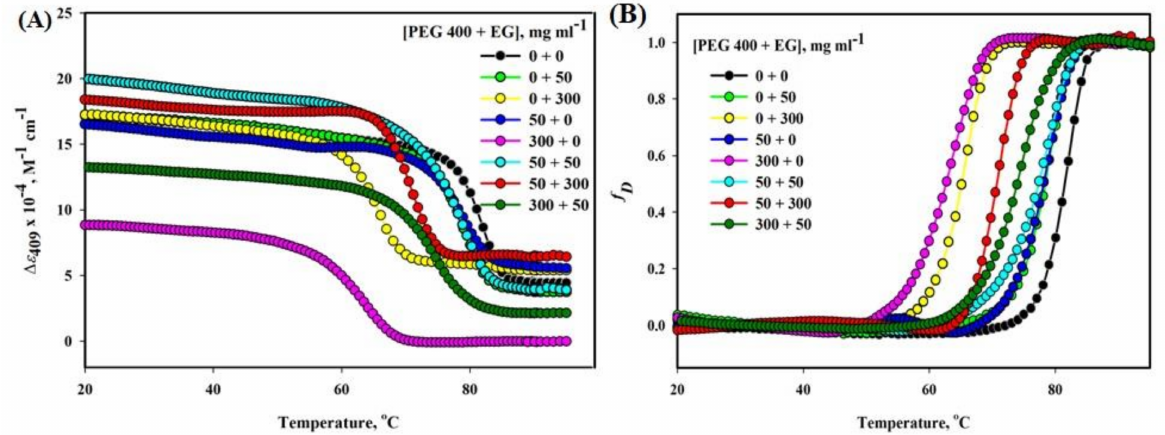
Figure 6. Heat-induced denaturation curves of Mb with different concentration mixtures of PEG 400 + EG, mg mL − 1 measured using ( A ) probe ε 409 and ( B ) fraction of denatured protein ( f D ) plot.